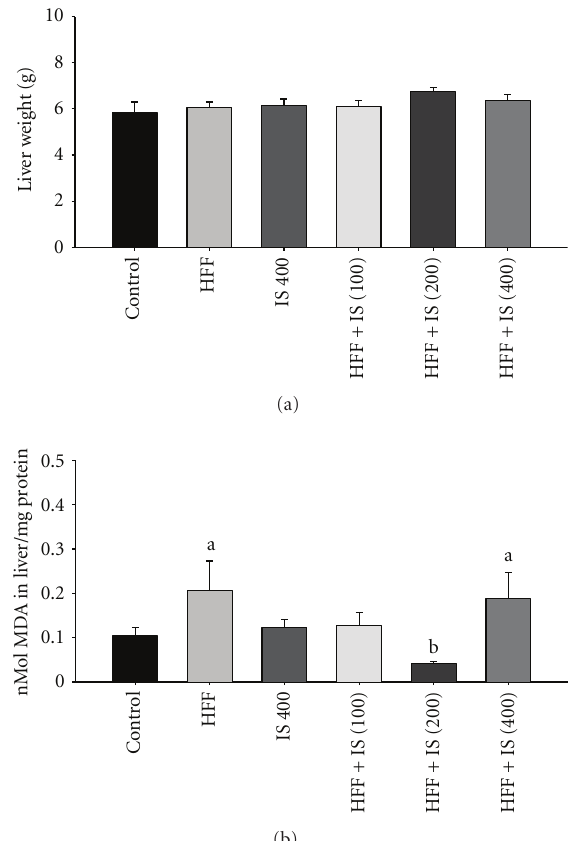
Figure 4: (a) Weight and (b) lipid peroxidation levels in liver of mice fed a high-fat diet plus fructose (HFF) and treated with I. sonorae (IS) for 8 weeks; a: significant di ff erence compared to Control; b: significant di ff erence compared to HFF, P < 0 . 05 (one way ANOVA, Tukey’s post hoc